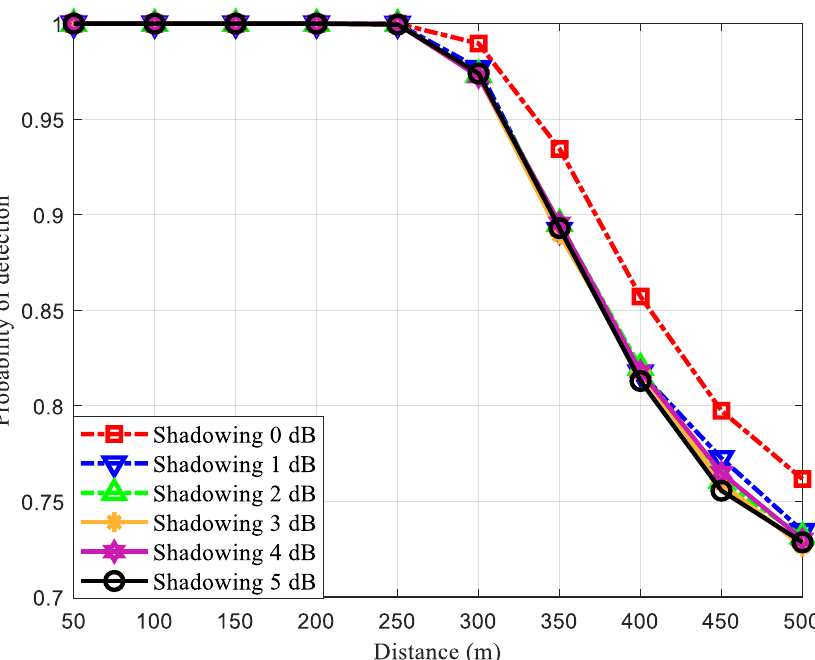
Figure 3. Investigation of the performance of Q d as a function of distance of the OR